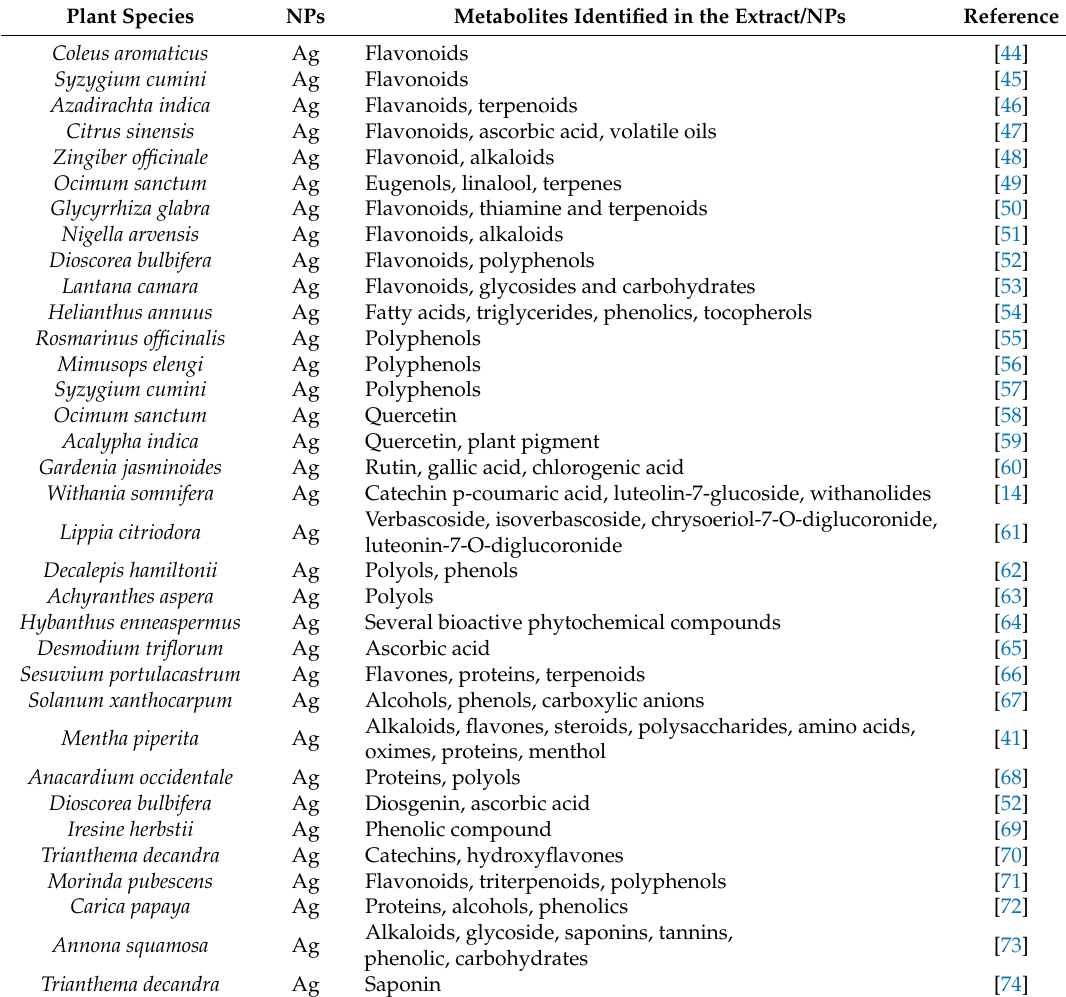
Table 1. Plant components possibly involved in the green synthesis of nanoparticles from various plant